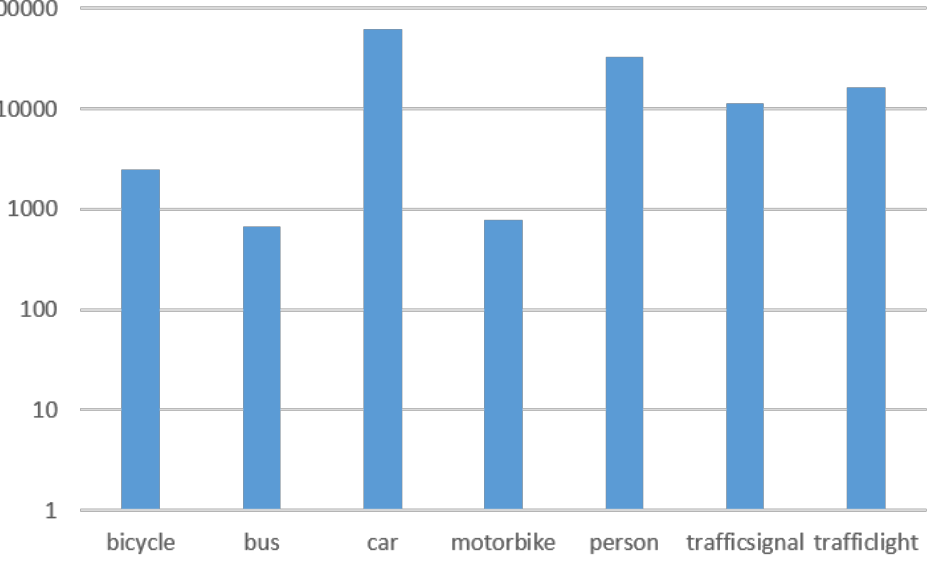
Figure 9. Final number of annotations per class included in the proposed